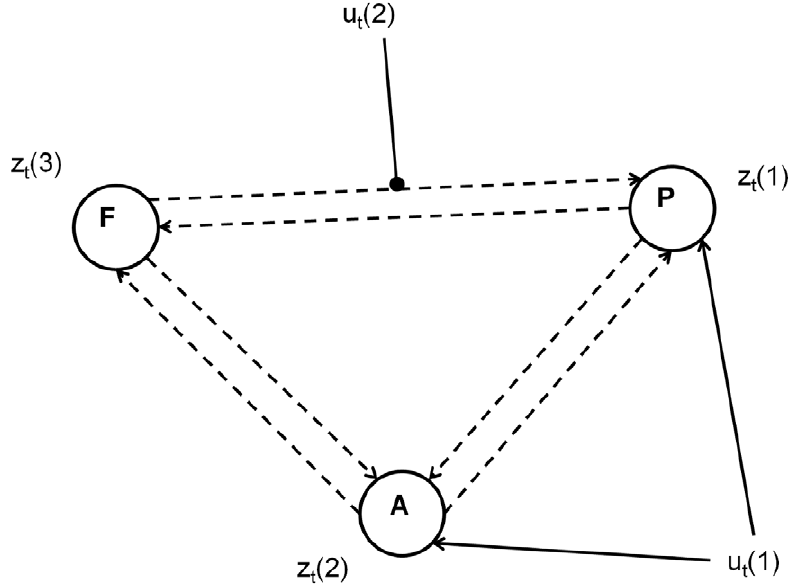
Figure 1. Dynamic Causal Models. The DCMs in this paper were used to analyse fMRI data from three brain regions: (i) left posterior temporal sulcus (region P), (ii) left anterior superior temporal sulcus (region A) and (iii) pars orbitalis of the inferior frontal gyrus (region F). The DCMs themselves comprised the following variables; experimental inputs u t (1) for auditory stimulation and u t (2) for speech intelligibility, a neuronal activity vector z t with three elements (one for each region P, A, and F), exogenous connections specified by the three-by-three connectivity matrix A (dotted arrows in figure), modulatory connections specified by three-by-three modulatory matrics B j for inputs j ~ 1 :: 2 (the solid line ending with a filled circle denotes the single non-zero entry for this particular model), and a 3-by-2 direct input connectivity matrix C with non-zero entries shown by solid arrows. The dynamics of this model are govenered by equation 1. All DCMs in this paper used all-to-all endogenous connectivity ie. there were endogenous connections between all three regions. Different models were set up by specifying which regions received direct (auditory) input (non- zero entries in C ) and which connections could be modulated by the speech intelligibility (non-zero entries in the matrix B 2 ).